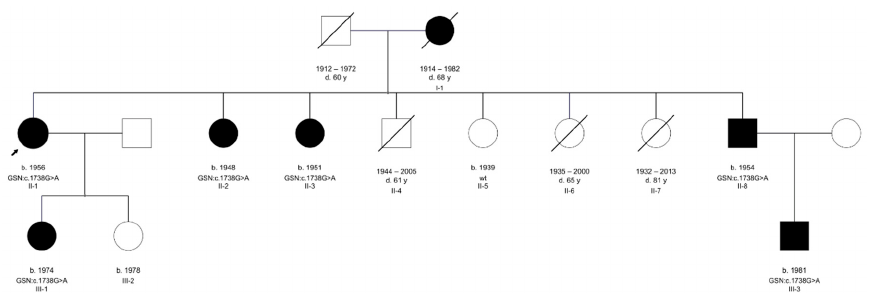
Figure 7. Three-generation family tree of seven members, six of them affected, is presented. Proband is indicated with an arrow. The genotypes of available family members are subscribed indicating the cosegregation of the identified GSN variant with the phenotypic features.